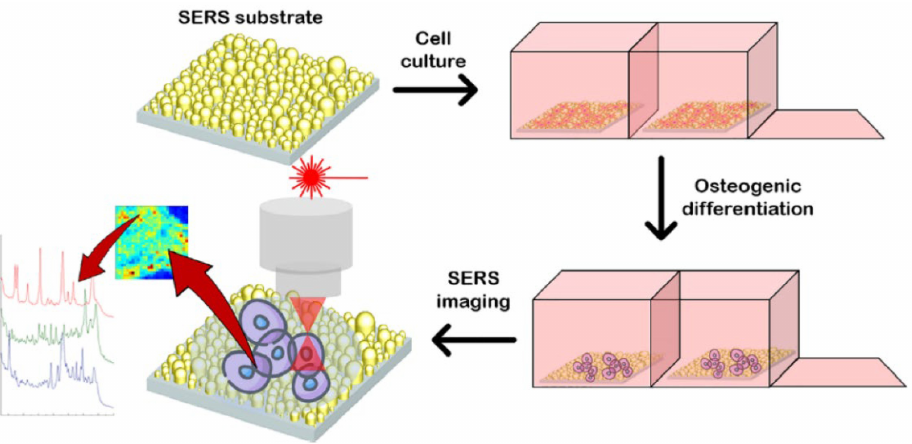
Figure 5. Schematic illustration of label-free SERS monitoring differentiation of BM-MSCs using gold substrate. Adapted with permission from Ref. [192]. Copyright 2021 American Chemical